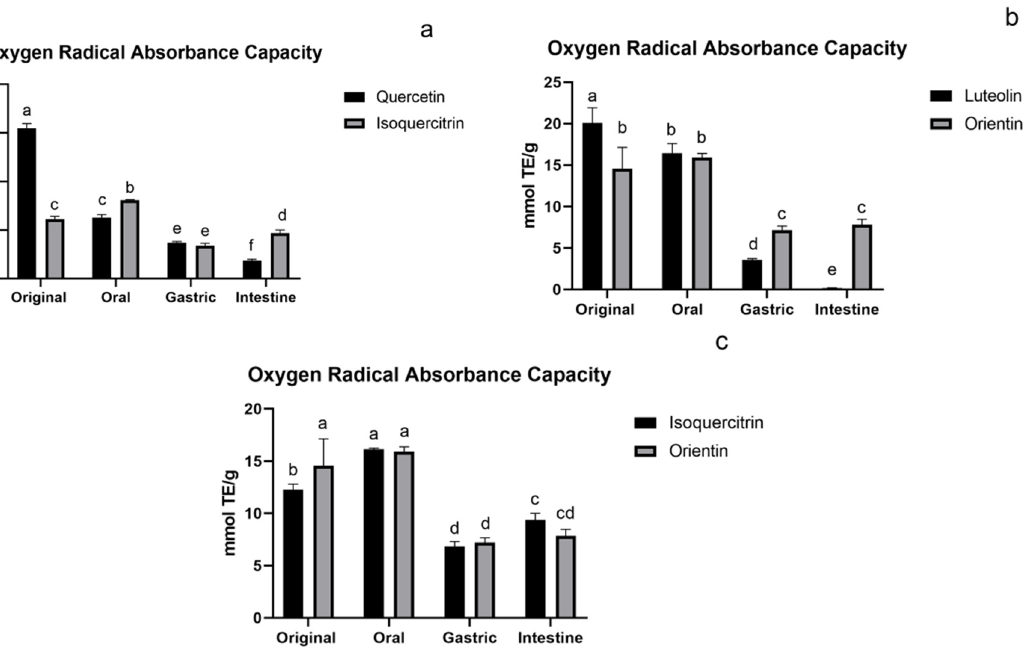
Figure 5. ORAC assay of flavonoids: ( a ) flavonoid O-glycoside and its aglycone, ( b ) flavonoid C-glycoside and its aglycone, and ( c ) flavonoid O-glycoside and flavonoid C-glycoside. The results are reported as means ± SD. Different letters in the figure indicate significant differences ( p < 0.05).